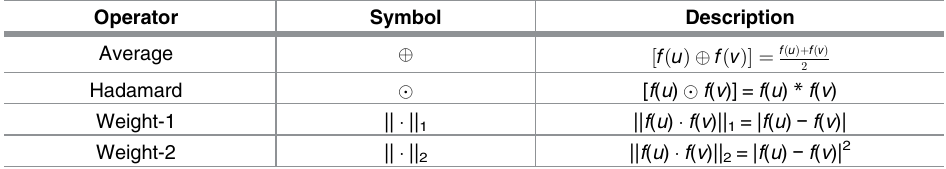
Table 3. Binary operators for learning the edge vector representations.